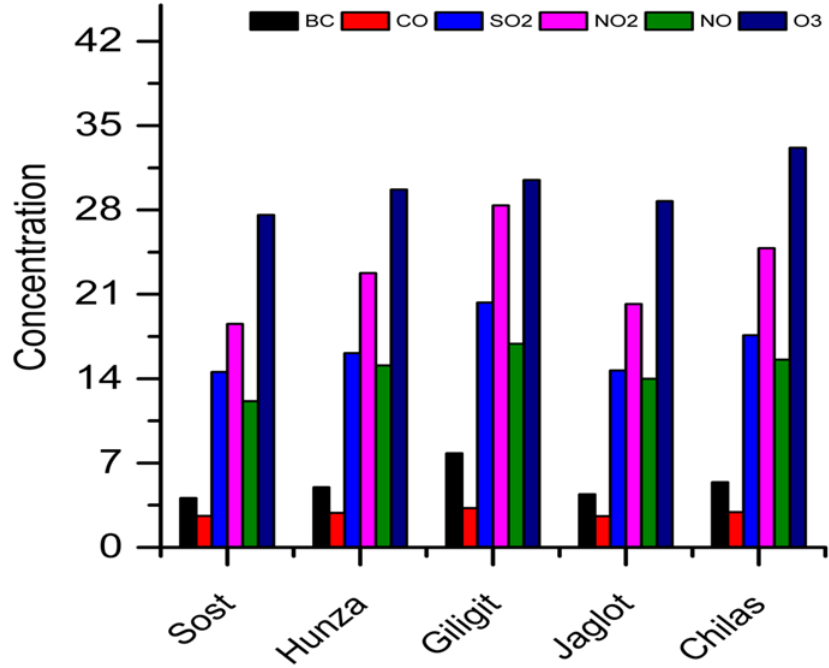
Figure 7. The daily average air quality indicators at all study sites during summer, 2020. Table 4. Meteorological conditions at the study locations during the winter and summer seasons.